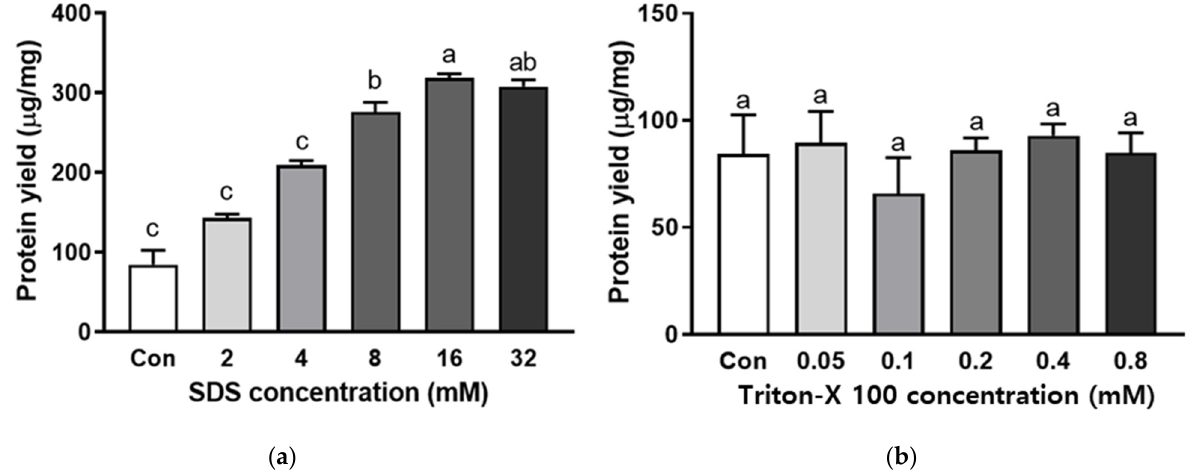
Figure 3. Protein extraction yield with different surfactant concentrations of ( a ) SDS and ( b ) Triton X-100 in phosphate buffer with EDTA. Bars with different letters are significantly different ( p < 0.05).